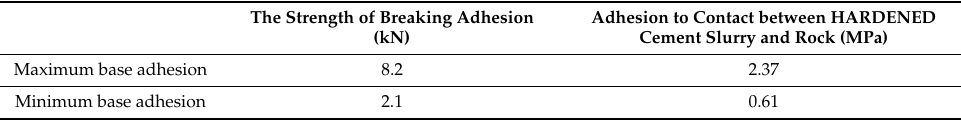
Table 3. Base adhesion to the contact between hardened cement slurry and rock.